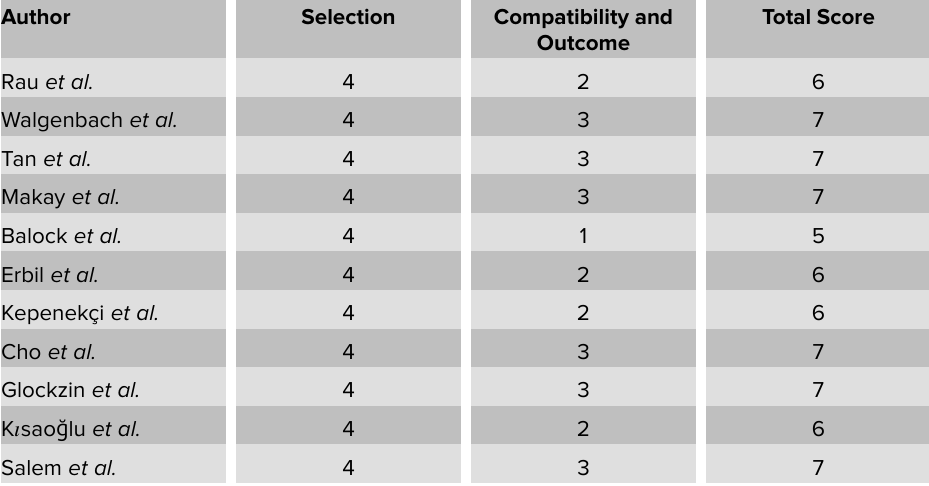
TABLE 1: The quality of the selected studies determined using the Newcastle–Ottawa